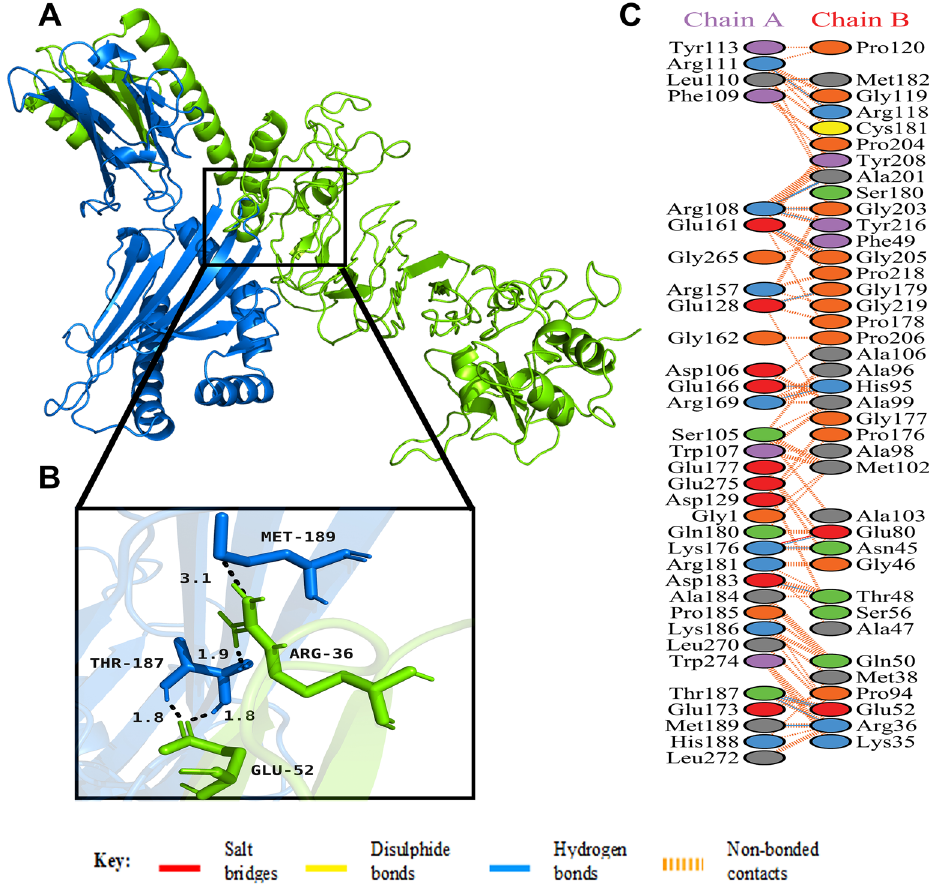
Figure 7. ( A ) Figure acquired after molecular docking which shows docked MHC class I receptor-vaccine complex. The vaccine construct is shown in green while the MHC class I receptor is shown in blue. ( B ) Residue interaction between the docked MHC class I receptor (chain A) and the vaccine (chain B). ( C ) Few hydrogen bonds shown within vaccine-MHC class I receptor complex are